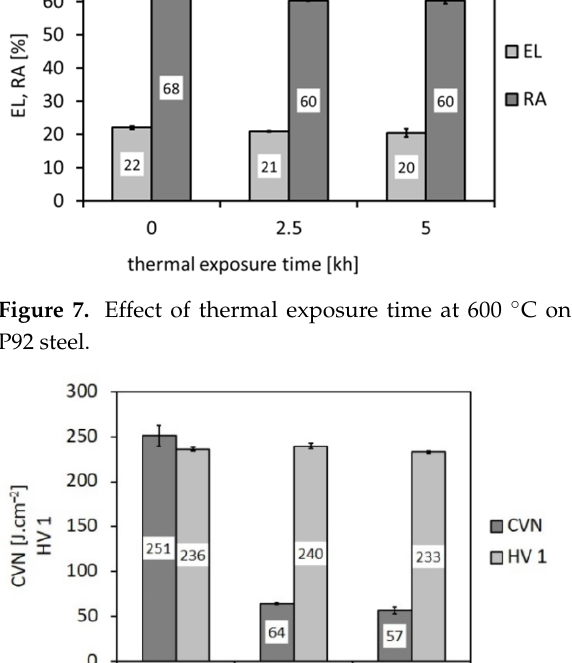
Figure 7. Effect of thermal exposure time at 600 °C on deformation properties of investigated P92 steel.